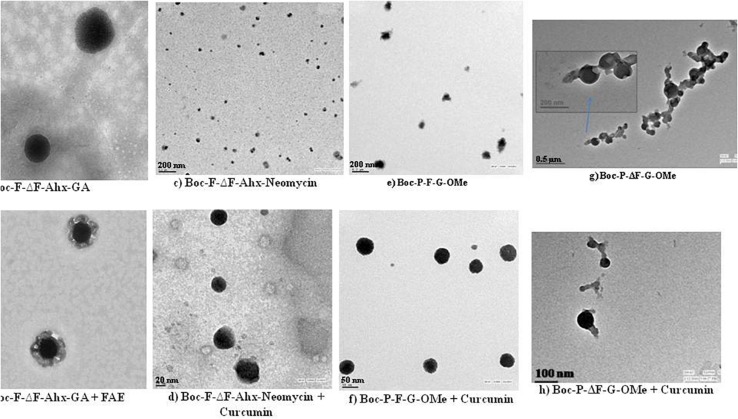
TEM images of (a) Boc-F-ΔF-Ahx-GA dipeptide, (b) FAE-loaded Boc-F-ΔF-Ahx-GA dipeptide, (c) Boc-F-ΔF-Ahx-Neomycin dipeptide, (d) Curcumin-loaded Boc-F-ΔF-Ahx-Neomycin dipeptide, (e) Boc-P-F-G-OMe tripeptide and (f) Curcumin-loaded Boc-P-F-G-OMe tripeptide; (g) Boc-P-ΔF-G-OMe tripeptide and (h) Curcumin-loaded Boc-P-ΔF-G-OMe tripeptide. (a and b: Reproduced from Reference (Mahato et al., 2012) with permission from the Royal Society of Chemistry; c and d: Reproduced from reference (Yadav et al., 2014a) with permission from the Royal Society of Chemistry; e and f: Reproduced from reference (Yadav et al., 2015) with permission from Bentham Science Publishers; g and h: Reproduced from reference (Deka et al., 2017) with permission from Elsevier.